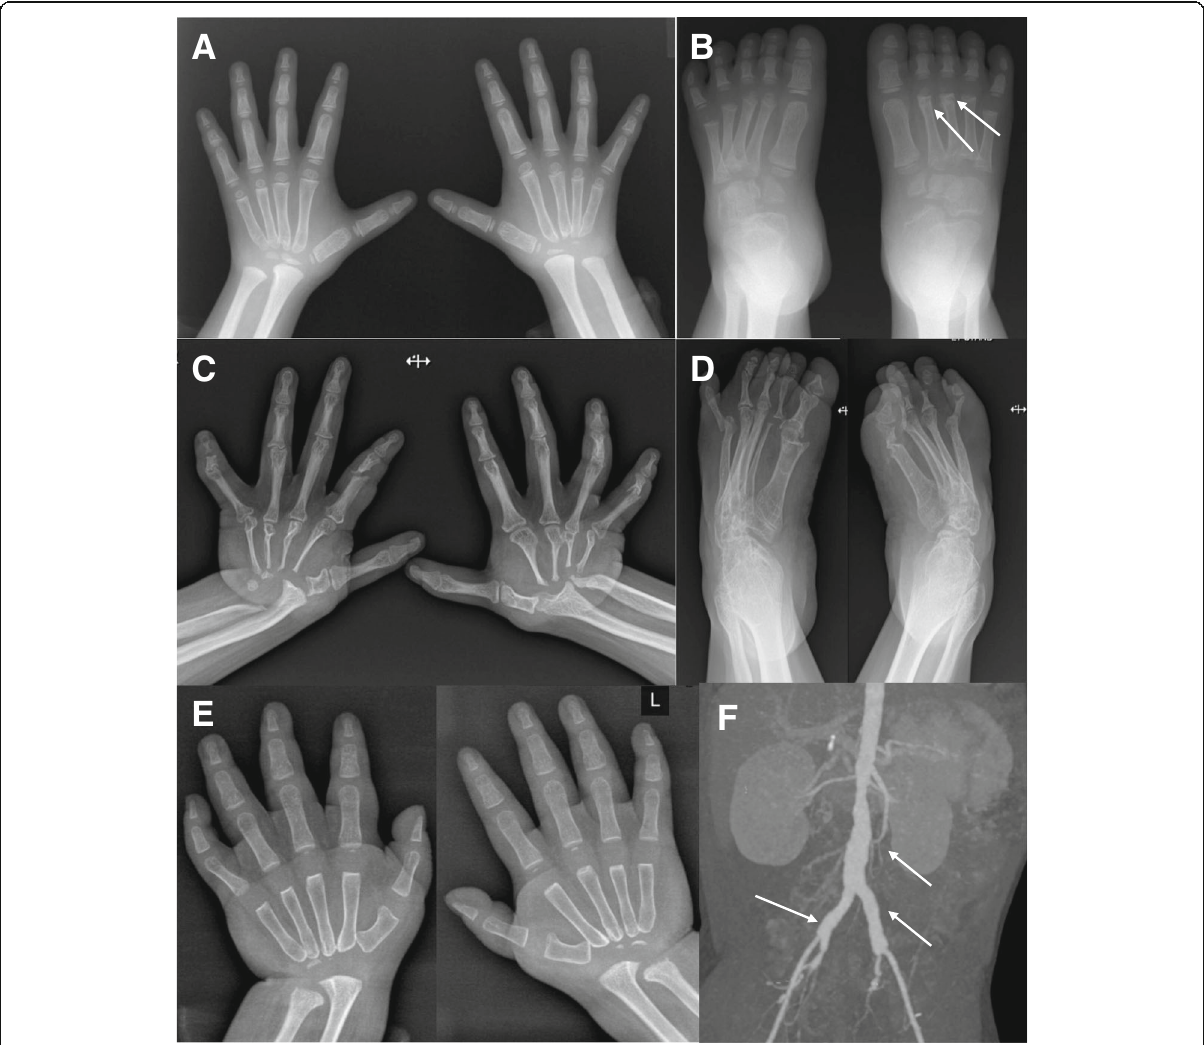
Fig. 1 Radiological findings of 2 patients with multicentric carpotarsal osteolysis syndrome. In Patient 1, radiographs of the hands ( a ) and feet ( b ) obtained at 4 years old show severe bone resorption of the carpal and tarsal bones. Bone erosions are also noted in the proximal ends of metacarpal and metatarsal bones and the distal ends of the talus and calcaneus. Note that the distal metacarpal and metatarsal bones and the phalanges remained well-preserved at that time. Incidentally, there are fractures of the left 2nd and 3rd metatarsal necks (arrows). Follow-up radiographs of the hands ( c ) and feet ( d ) at the age of 20 show marked progression of bone resorption and associated joint contracture. In addition to the carpal and tarsal bones, the metacarpal and metatarsal bones, phalanges, distal radii, and ulnae are extensively involved. In Patient 3, radiographs of the hands ( e ) and feet (not shown) obtained at 1 year of age show multiple areas of osteolysis predominantly involving the carpal and tarsal bones. In addition, an abdominal aortic aneurysm was incidentally detected with renal ultrasonography (not shown), and a subsequently taken abdominal CT angiograph ( f ) confirmed fusiform aneurysms involving the infrarenal aorta and bilateral common iliac arteries